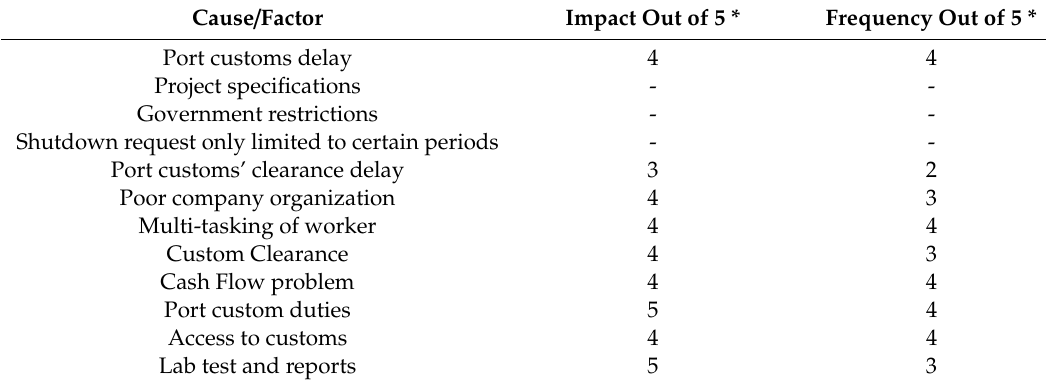
Table 4. Extra Factors added through the